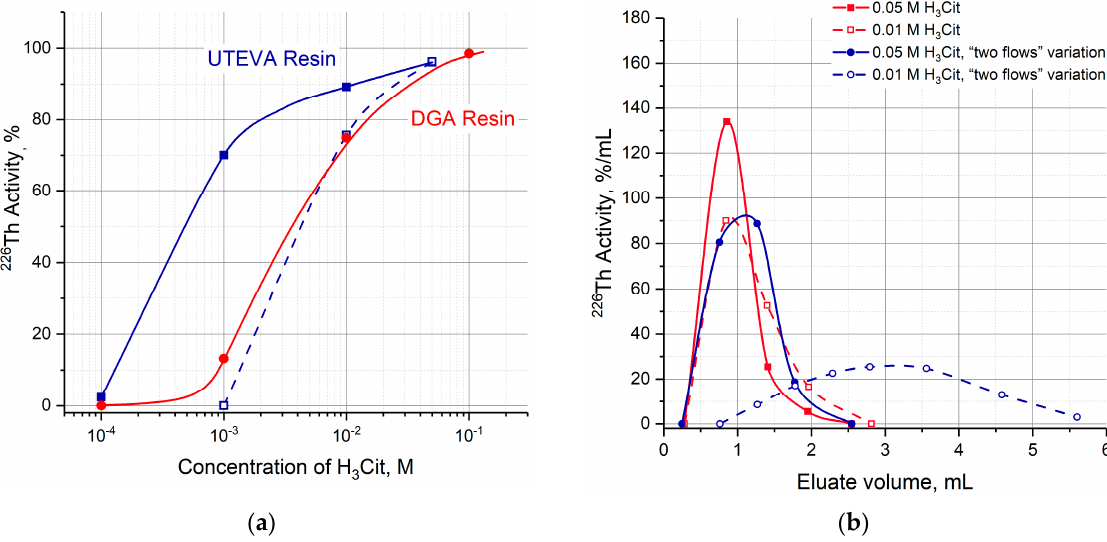
Figure 11. ( a ) Efficiency of 226 Th desorption from the pre-treated DGA and UTEVA resin columns as a function of citric acid concentration (pH 5.0). DGA resin column pre-treated with 0.1 M HNO 3 (red solid curve); UTEVA resin: Pre-treated with 3 M HNO 3 (blue solid curve), pre-treated with 3 M HNO 3 + “two flows” variation of 226 Th transfer (blue dashed curve); ( b ) curves of 226 Th elution depending on the variations of 226 Th recovery from UTEVA columns.